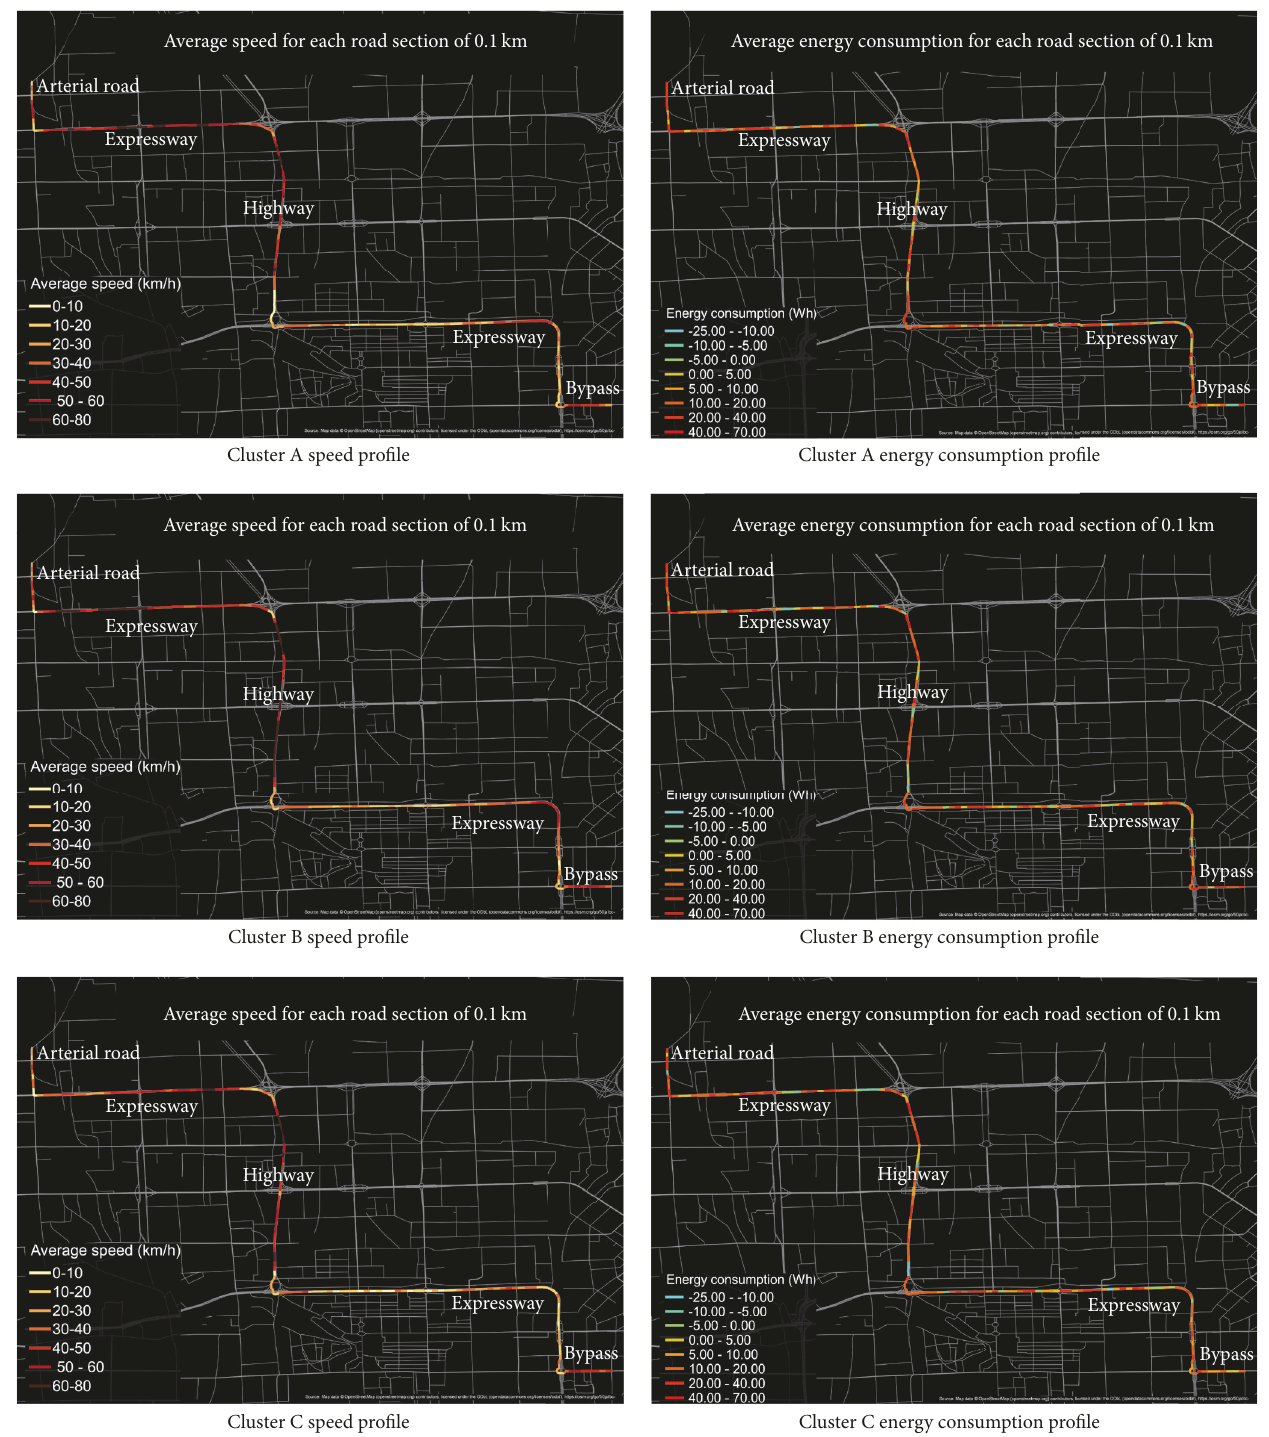
Figure 14: Speed and energy consumption profiles for different clusters in congested